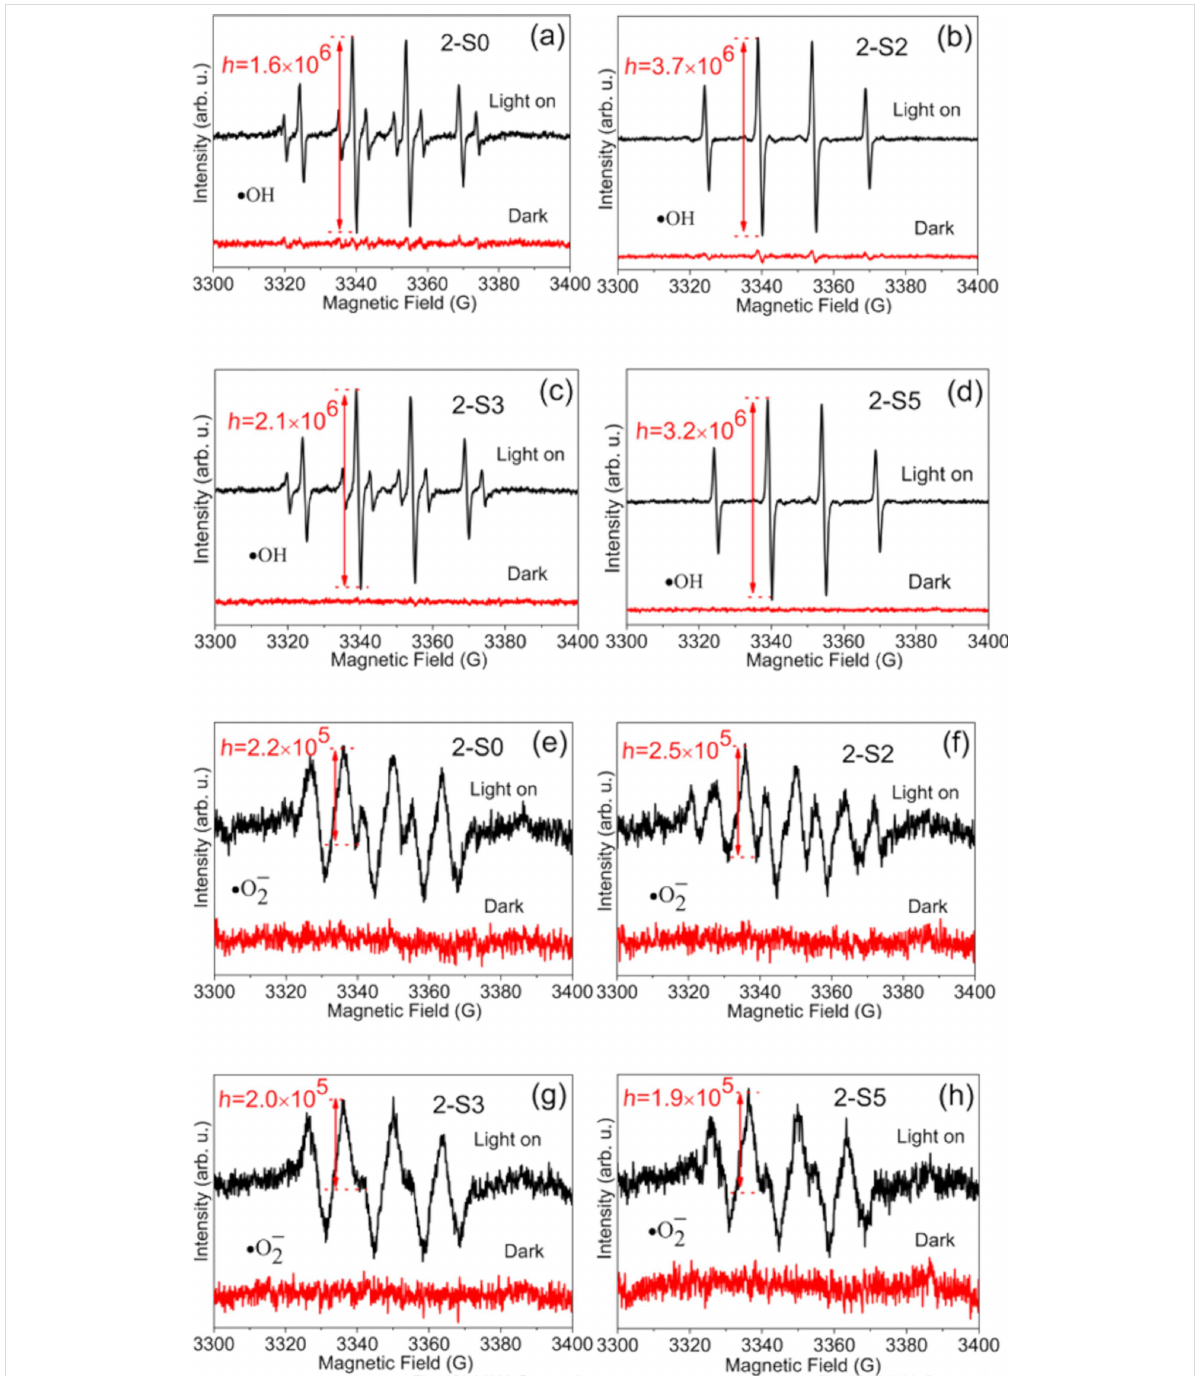
Figure 10: ESR spectra of radical adducts trapped by DMPO in 2-S0 (a, e), 2-S2 (b, f), 2-S3 (c, g), and 2-S2 (d, h) dispersions: (a, b, c, d) DMPO–•OH formed in aqueous dispersions, (e, f, g, h) DMPO–•O 2 − formed in methanol dispersion.